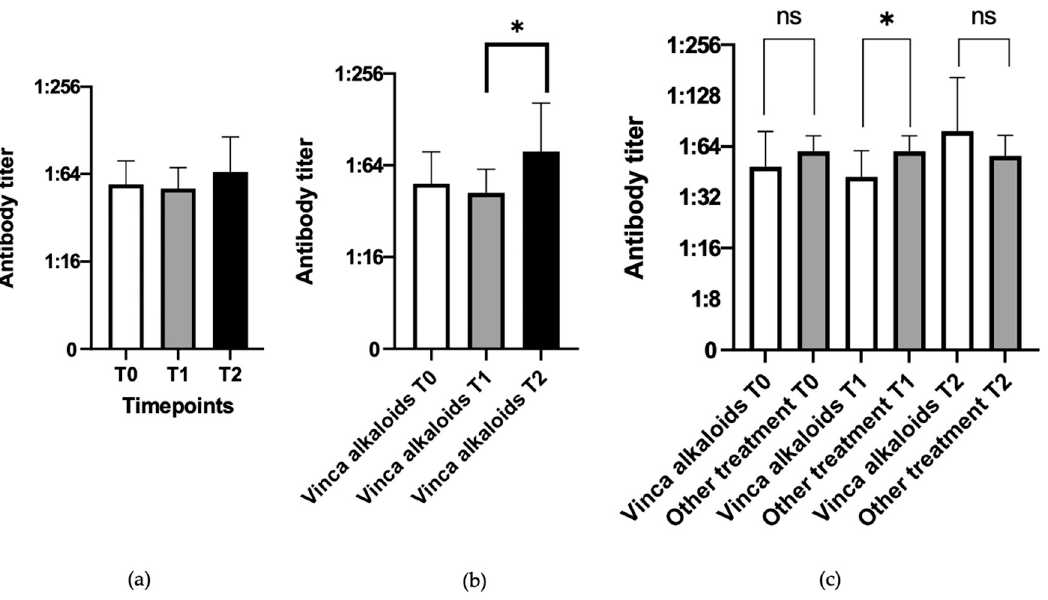
Figure 1. Antibody titers toward distemper at different timepoints (Kruskal–Wallis test). ( a ) all dogs treated with different chemotherapy protocols ( n = 21 for each timepoint). ( b ) dogs treated with vinca alkaloids ( n = 10 for each timepoint). ( c ) dogs treated with vinca alkaloids ( n = 10) compared with dogs treated with other chemotherapy drugs ( n = 11) at T1 (Mann–Whitney test). Statistically signi fi cant di ff erences are indicated with *, and “ns” represents no statistical signi fi cant results.